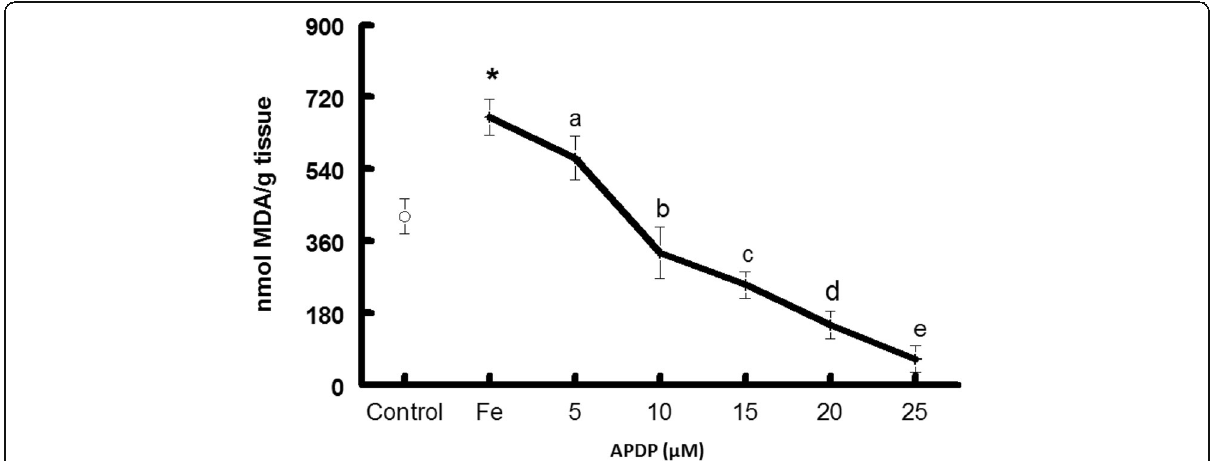
Fig. 2 Effect of 1-(2-(2-(2-(1-aminoethyl)phenyl)diselanyl)phenyl)ethanamine (APDP) on lipid peroxidation induced by 10 μ M iron (II)-induced in liver homogenates. Data show mean ± SD values averaged from four independent experiments performed in quadruplicate in different days Different letters indicate a significant difference in relation to the control (without pro-oxidant) and among the groups (with pro-oxidant) at p < 0.05. Asterisk shows significant effect of iron (II) at p < 0.05, Abbreviations: Fe — Iron